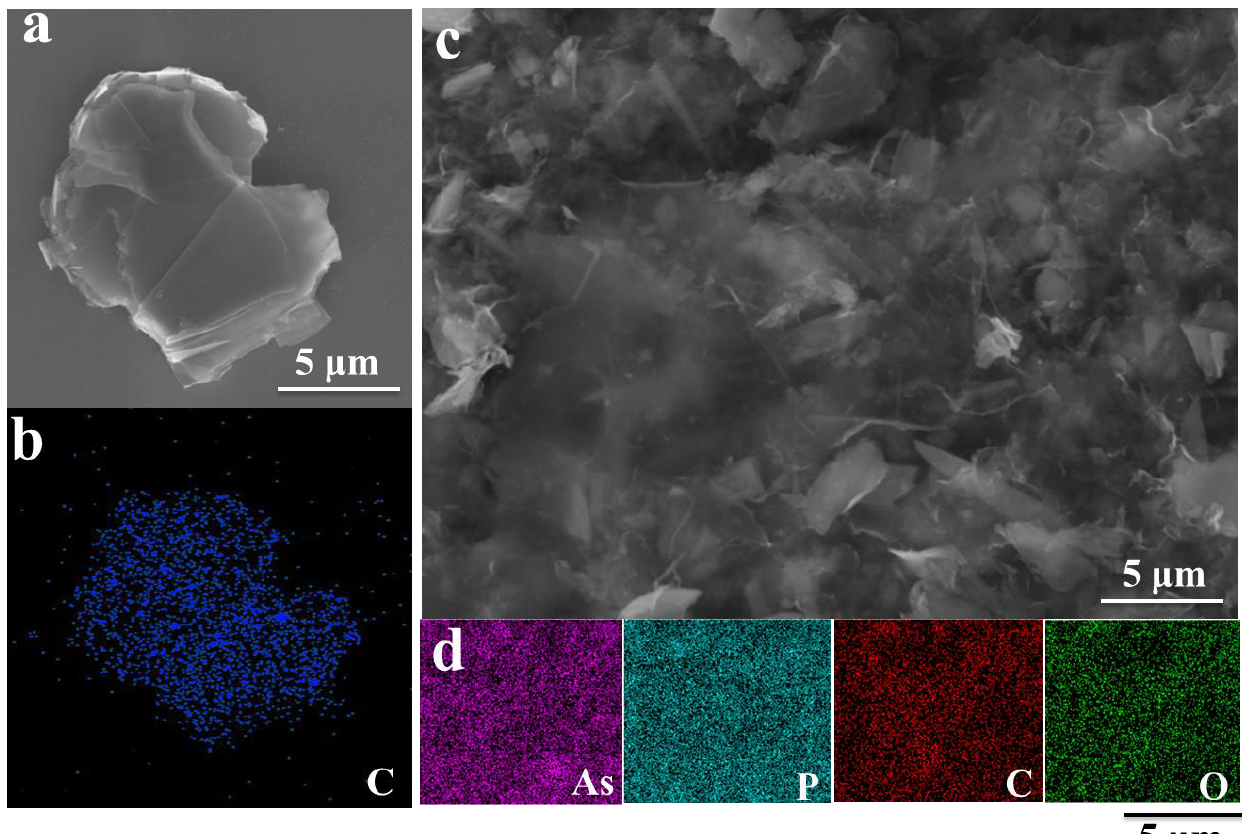
Figure 4. ( a ) SEM image and ( b ) EDS spectrum mapping of GO, ( c ) SEM image, and ( d ) EDS spectrum mapping of GO/B-AsP/CNTs.